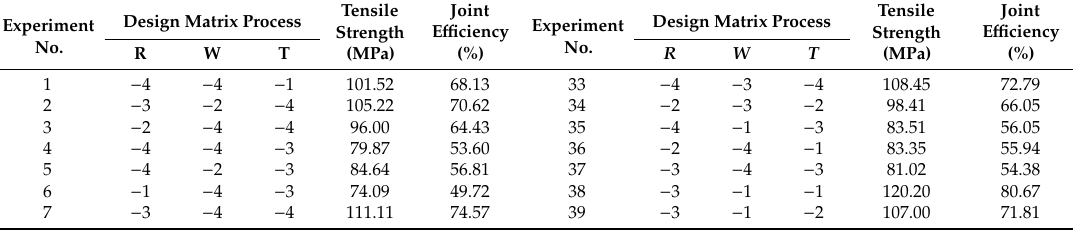
Table 4. The result of the experimental design of model 4 3 with 64 general full factorial designs. Experiment